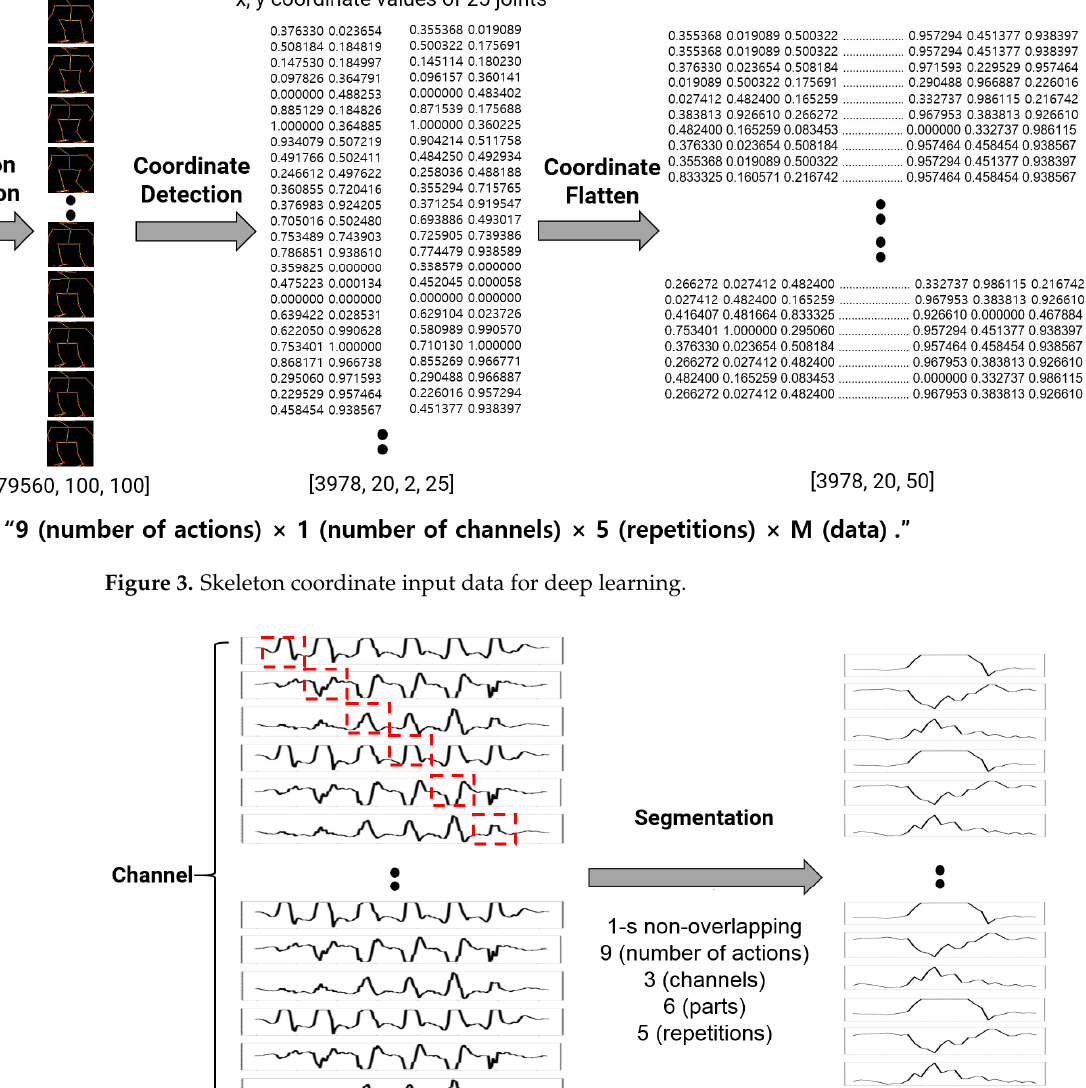
Figure 3. Skeleton coordinate input data for deep learning.